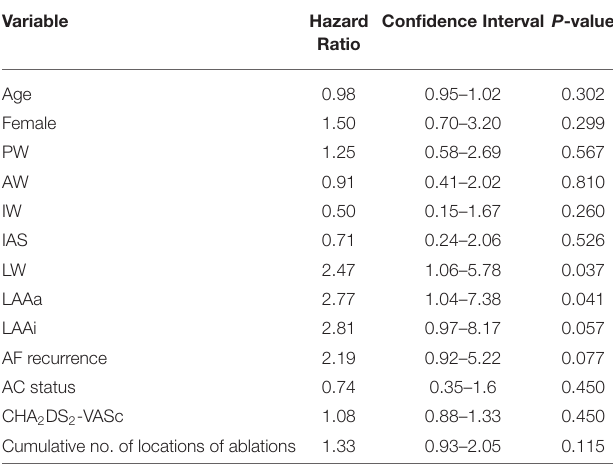
TABLE 4 | Univariate and multivariate analysis evaluating risk for ischemic stroke or transient ischemic attack. (A) Univariate analysis with cox proportional Hazard Ratios evaluating risk of IS/TIA*